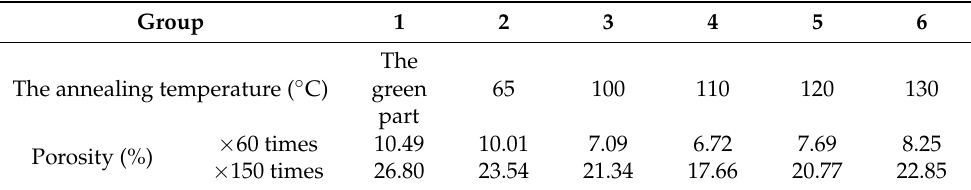
Table 2. The porosity of 10%-CPLA green parts and parts after thermal post-processing. Group The annealing temperature ( ◦